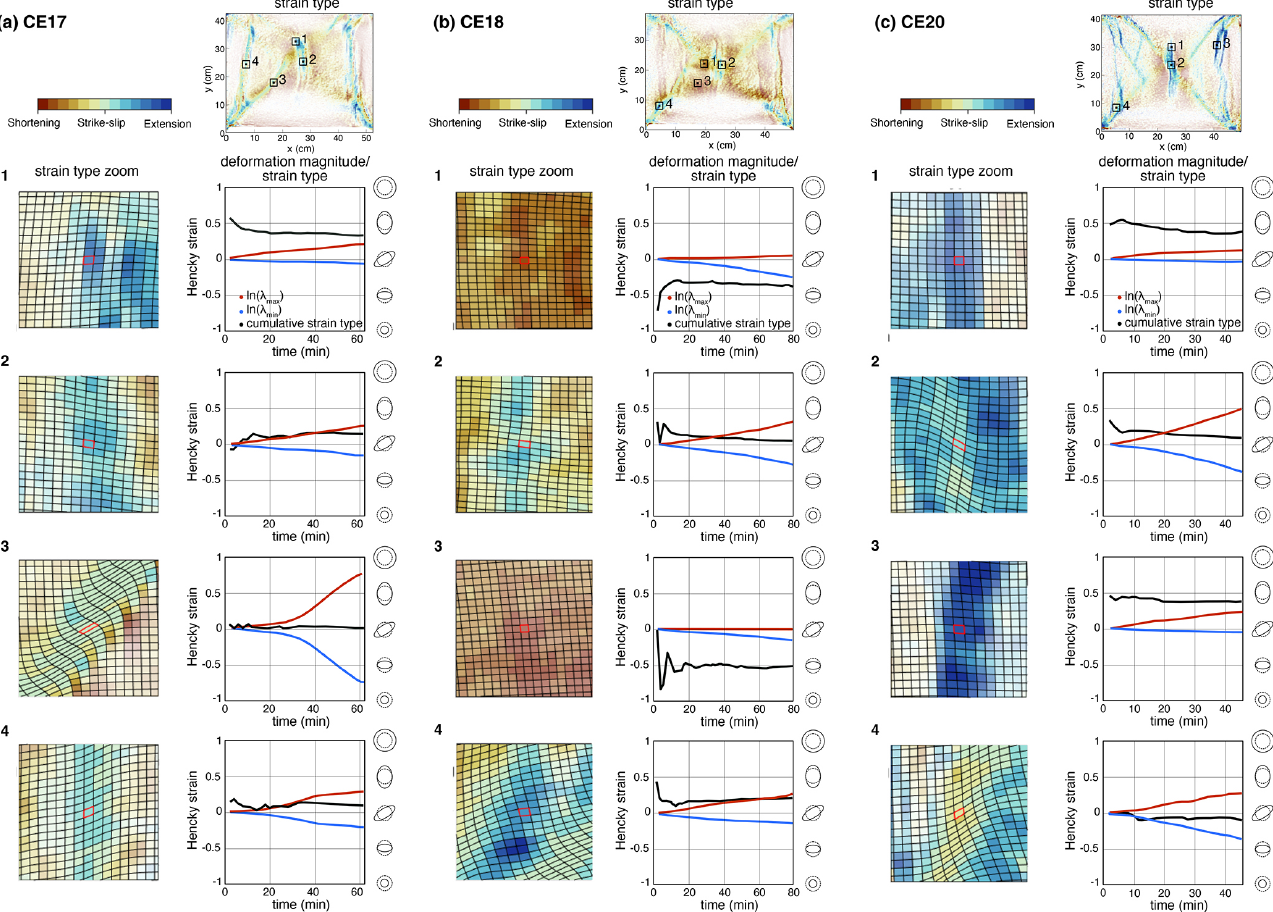
Figure 7. Temporal evolution of principal stretches and strain type during the second stage of deformation for points 1, 2, 3, and 4 in models (a) CE17, (b) CE18, and (c) CE20 (brittle–ductile crust). Upper right-hand panel: strain type (final) and overview of the selected areas. Left column: zoom on the strain type and the selected grid cell (which is outlined in red, with neighboring cells outlined in black). Right column: time evolution of the logarithm of the two principal stretches (Hencky strain; blue and red curves) and associated strain type (cumulative; black curve, right